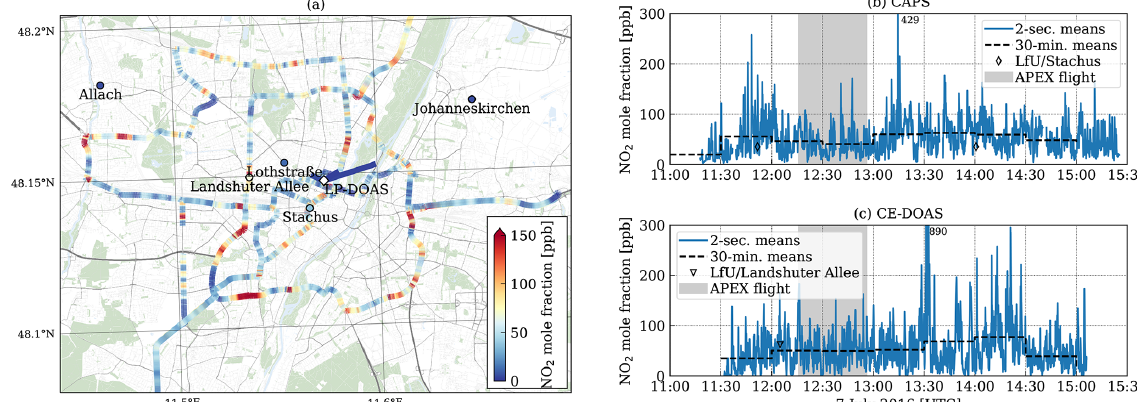
Figure 4. (a) Map of NO 2 mole fractions measured by LMU and MPIC vehicles in the afternoon. Locations of the LfU monitoring stations are shown as circles colored by the mean afternoon NO 2 mole fraction. Panels (b) and (c) show the time series of NO 2 mole fractions measured by the CAPS and CE-DOAS instruments on the LMU and MPIC vehicles, respectively. Map data from © OpenStreetMap contributors 2021. Distributed under the Open Data Commons Open Database License (ODbL) v1.0.